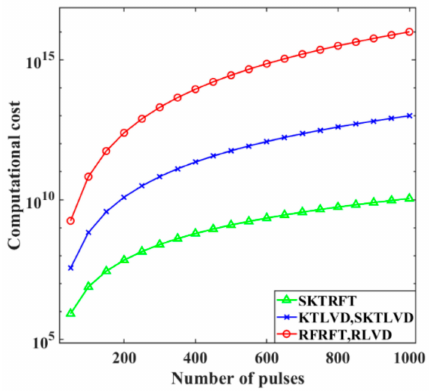
Figure 2. Computational costs of different